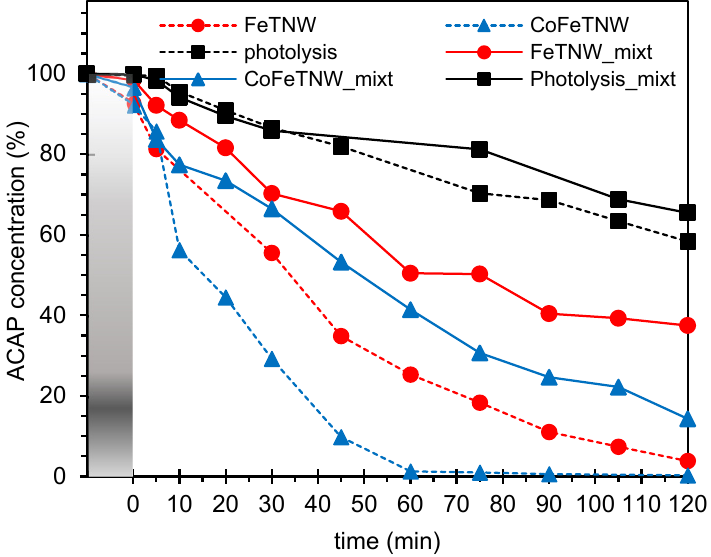
Figure 6. ACAP removal profiles for single and mixture solutions, during 120 min of irradiation, for photolysis and using FeTNW and CoFeTNW as catalyst photocatalysts (20 mg of catalyst to 150 mL of ACAP solution).